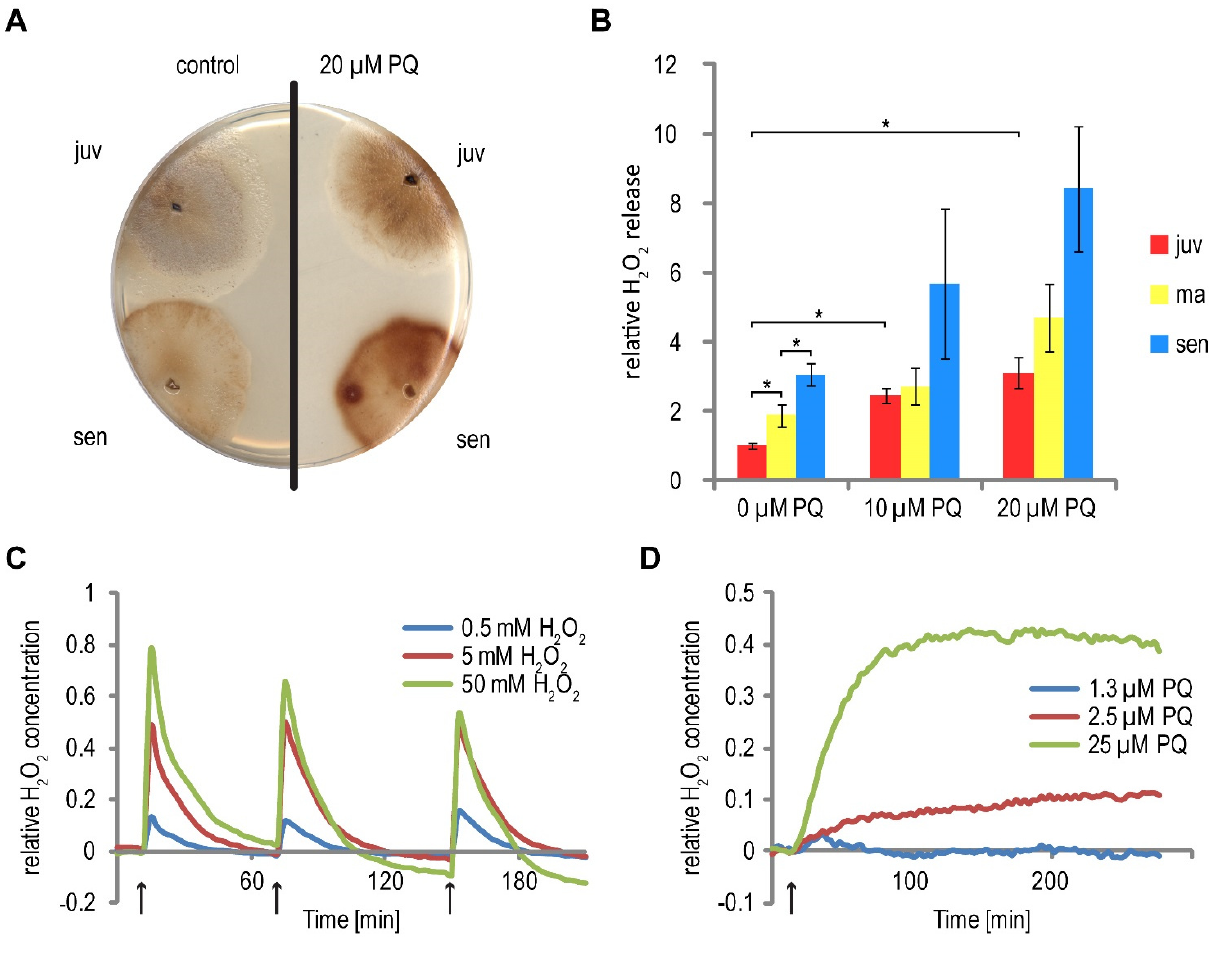
FIGURE 1: Increased hydrogen peroxide generation and release by P. anserina cultures during aging and PQ-stress. (A) After 2 days of ascospore germination, fungal mycelia were either directly challenged with 20 µM PQ (juv) or grown for 11 days on M2 medium to obtain a senescent stage. The cultures were subsequently incubated for 4 days on M2 with 20 µM PQ. As a control, both age stages (juv: 6 days; sen: 17 days) were cultivated on PQ-free M2 medium. After this time, DAB-staining-solution was poured on the cultures. The reaction with secreted H 2 O 2 leads to the formation of a dark brown pigment. (B) Quantitative measurement of H 2 O 2 release. P. anserina cultures were essentially grown as described in (A). Instead of on M2, cultures were grown on PASM medium until reaching a final age of 6 days (juv), 11 days (ma) and 15 days (sen), respectively. Concentrations of 0 µM, 10 µM and 20 µM PQ were administered. Bars indicate mean ± standard error of H 2 O 2 release relative to juvenile untreated cultures. n = 16 - 41. Asterisks indicate pV < 0.01. (C and D) Relative changes in H 2 O 2 concentration in the cytoplasm. P. anserina strains producing the redox sensitive HyPer protein, localized to the cytoplasm, were germinated for 2 days on germination medium and grown for 4 days on M2 agar plates. The mycelium was punched out of the agar, transferred to a 96 well plate and soaked in 60 µl water. Subsequently, H 2 O 2 (C) or PQ (D) was added at the indicated times (arrows) to a final concentration of 0.5 mM, 5 mM and 50 mM or 1.3 µM, 2.5 µM and 25 µM, respectively. The fluorescence of the mycelium after exitation at 488 ± 5 nm (oxidized HyPer) and 420 ± 5 nm (reduced HyPer) was measured at 530 ± 20 nm. The graphs show the ratio of oxidized to reduced HyPer normalized to a untreated HyPer